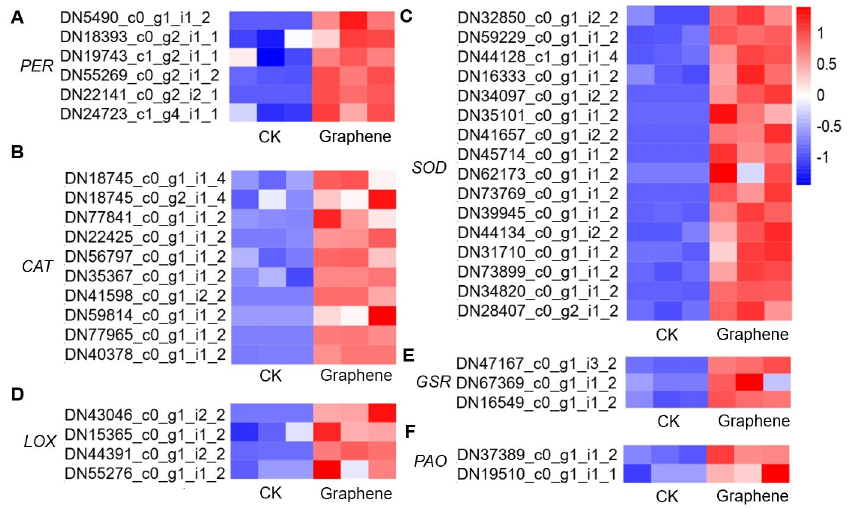
Fig 7. Selected metabolism related DEGs in response to